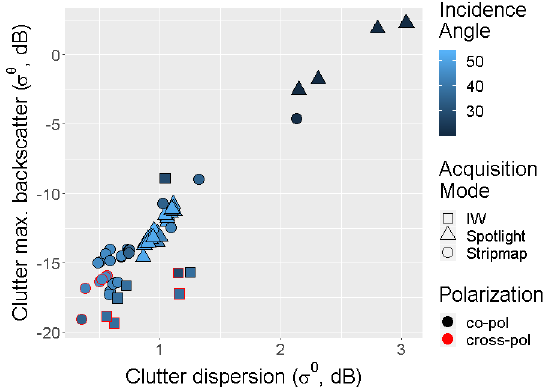
Figure 12. The water surface’s maximum backscatter and dispersion and its relation to different sensor